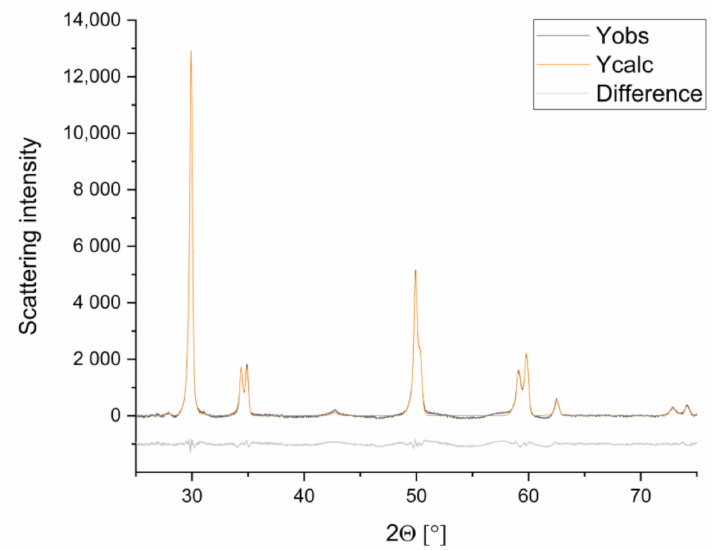
Figure 2. Comparison of a refined (Ycalc) and a measured (Yobs) graph, and the difference between the two graphs (used sample: 3y_PM (1)B), Rwp: